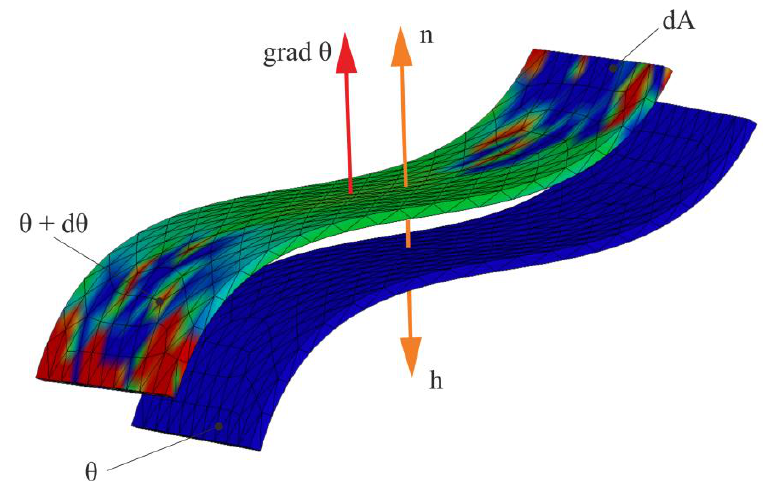
Figure 8. Heat transfer by thermal conduction.